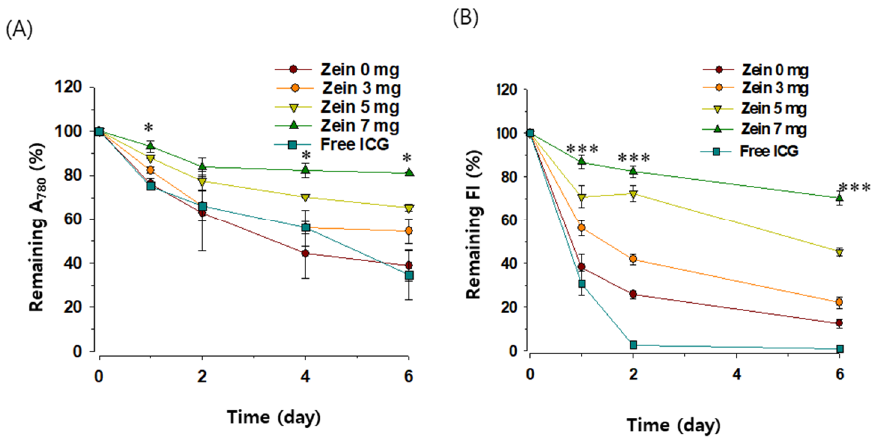
Figure 4. The effect of zein hybridization in PC-NP on the time-dependent degradation of encapsulated ICG. ICG degradation was assessed by changes in absorbance ( A ) and FI ( B ) of ICG (0.1 mg/mL) during storage at room temperature. The value on day 0 was set at 100%. Each point represents the mean ± SD; n = 3. Significant differences between the PC-NP with or without zein hybridization are indicated by asterisks: * p < 0.05; *** p <